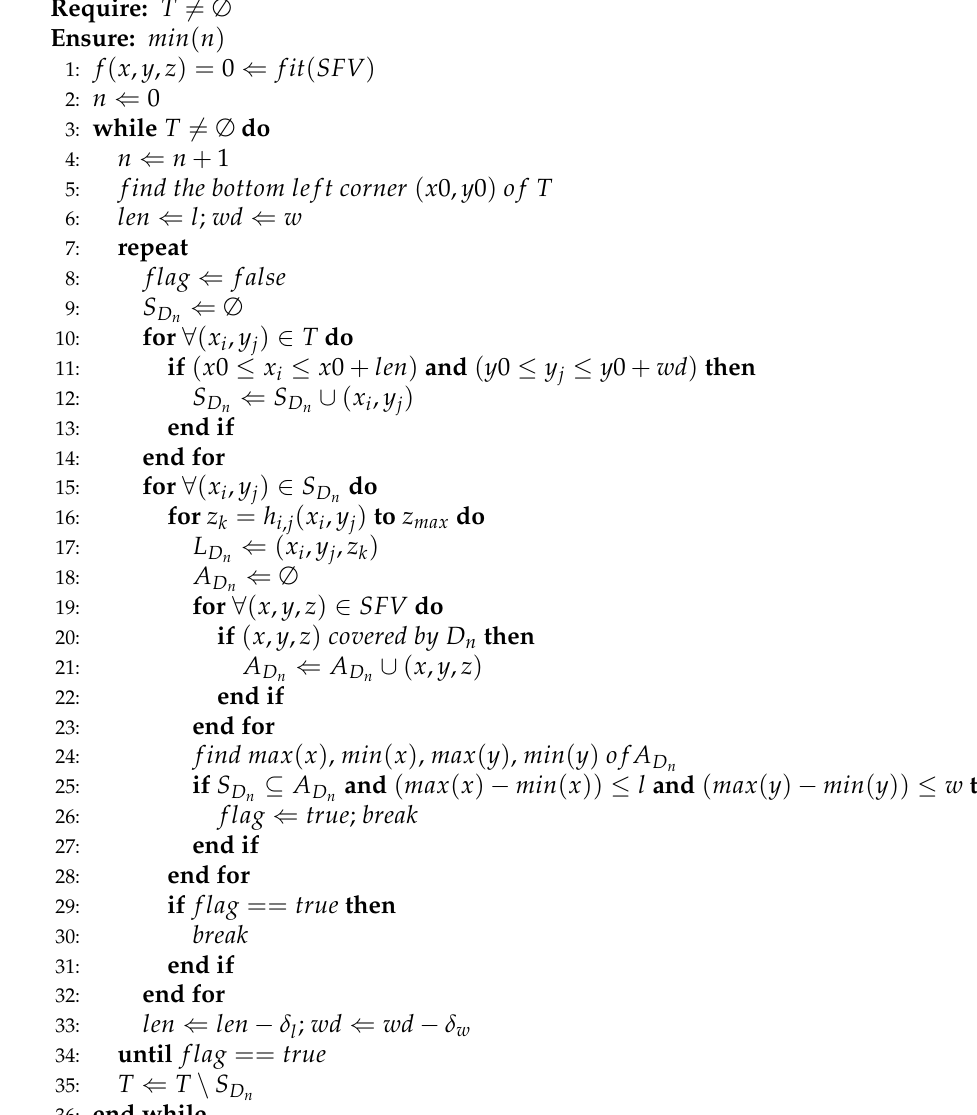
Algorithm 2: Area Division: Calculate S D